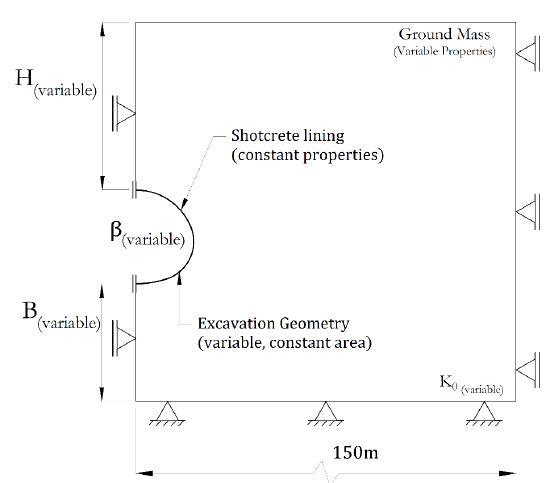
Figure 4. Basic hierarchy H1 model structure for the parametric analysis.